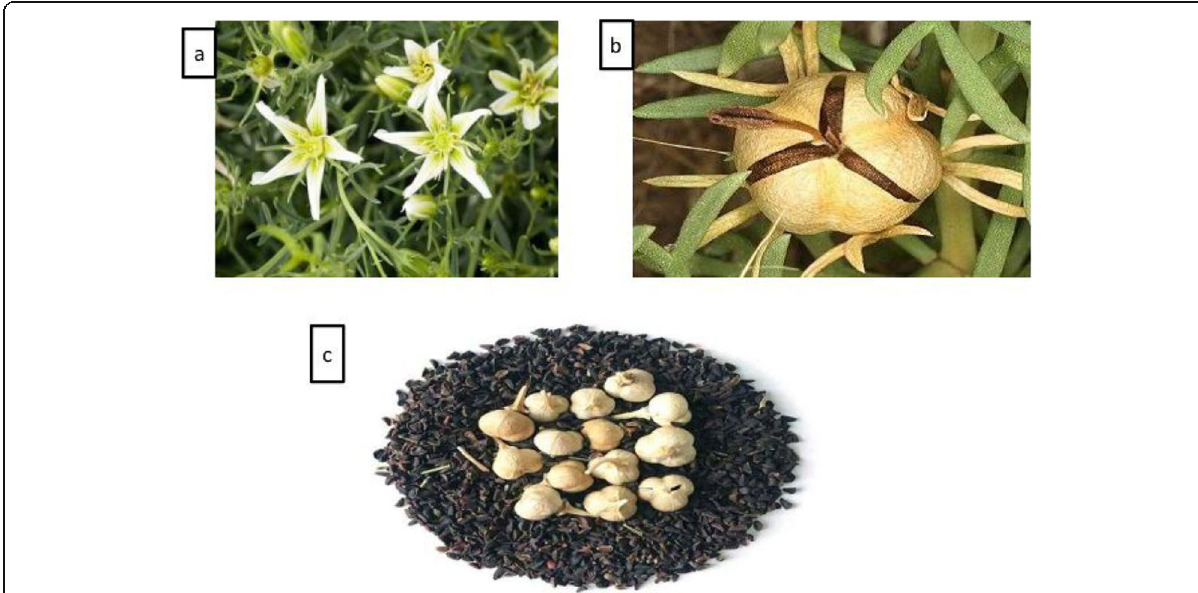
Fig. 1 Various parts of P. harmala a Leaves and Flowers, b Fruit, c